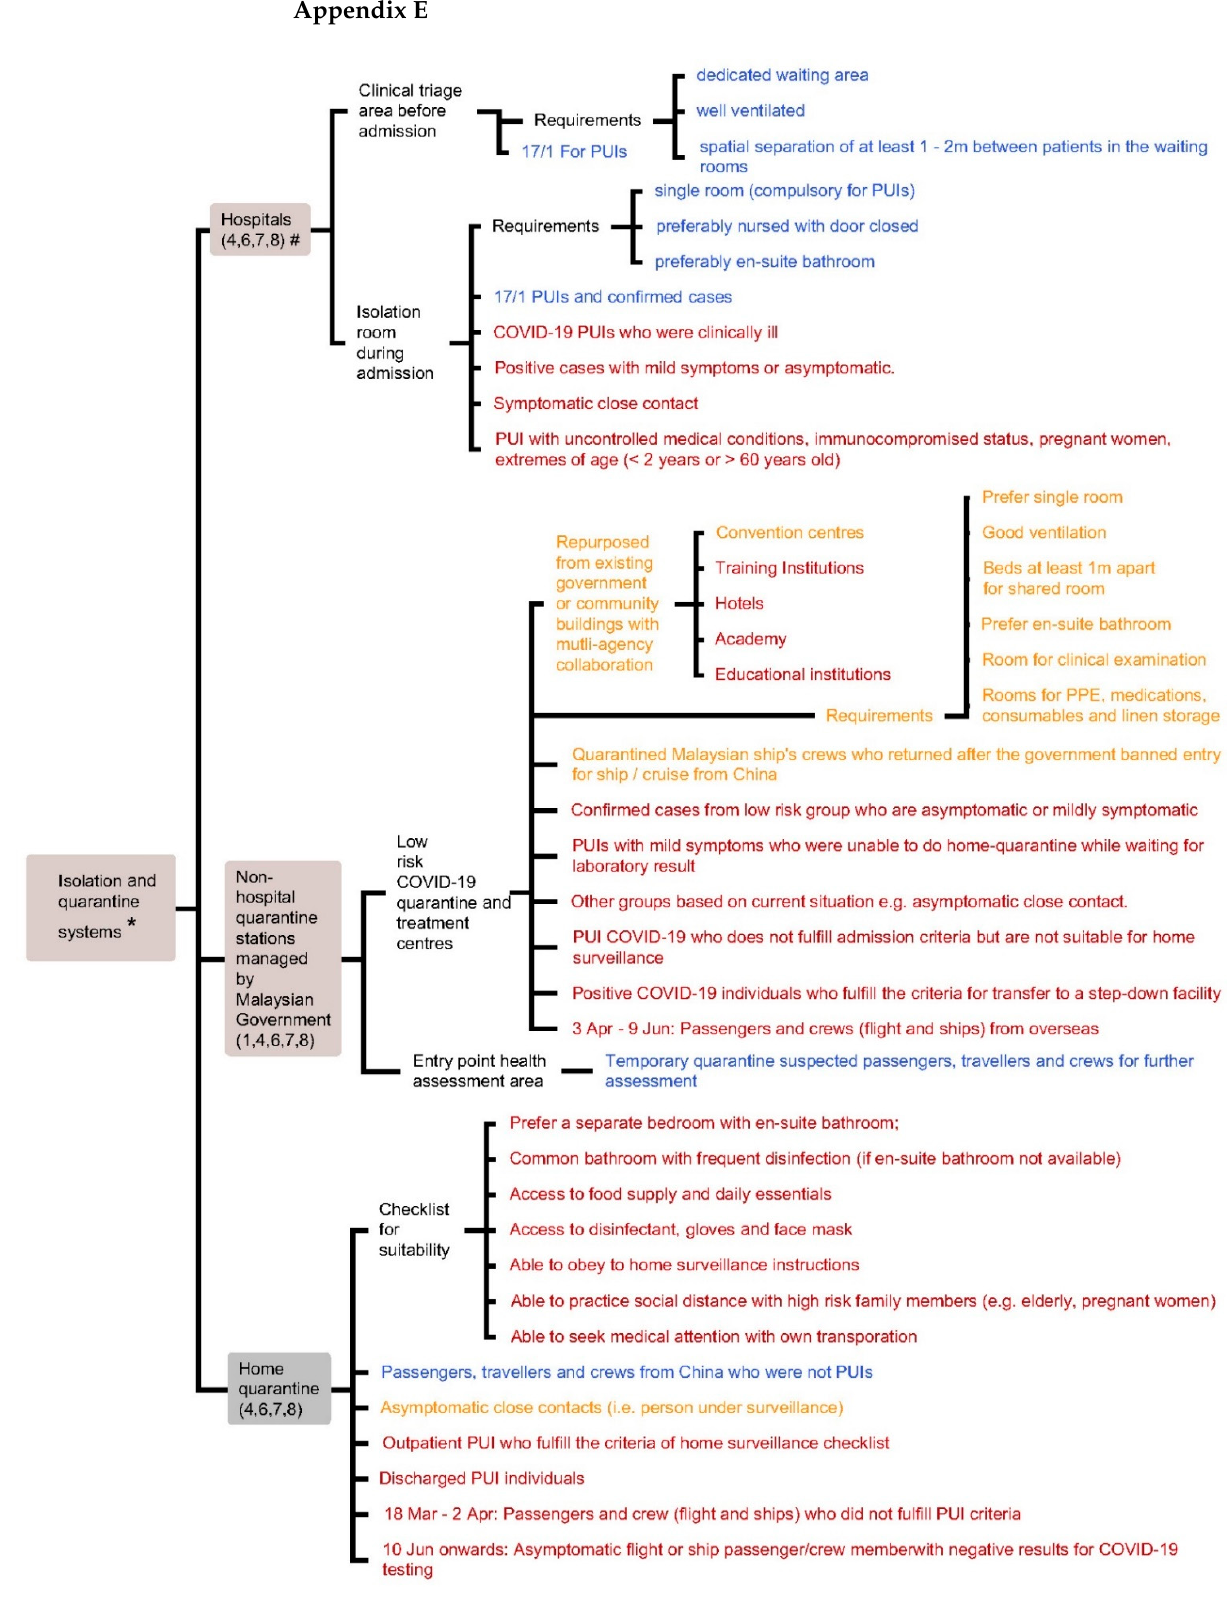
Figure A3. Isolation and quarantine systems employed by Malaysia. # Numbers in parentheses denote WHO Pillars. * Measures implemented: (i) before the first wave (31 December to 24 January) indicated in blue, (ii) during the first wave (25 January 26 February) indicated in orange, and (iii) during the second wave (27 February onwards) indicated in red.